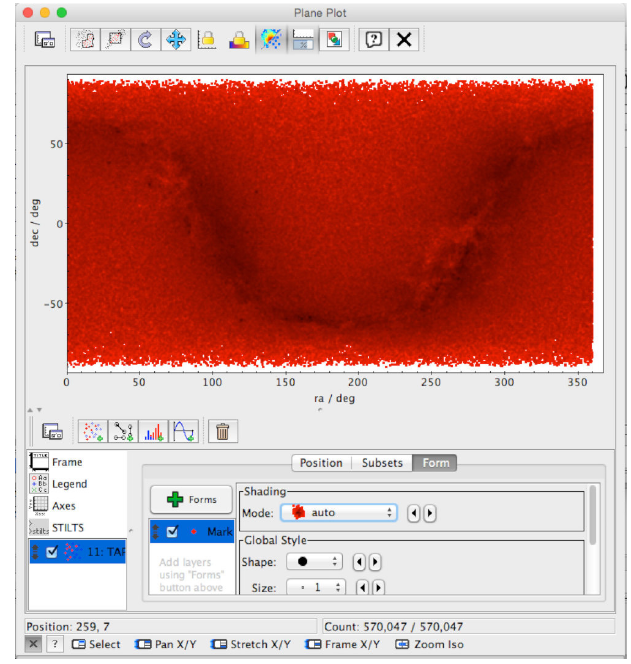
Fig. 60.— The brightest stars from the Gaia DR2 catalog